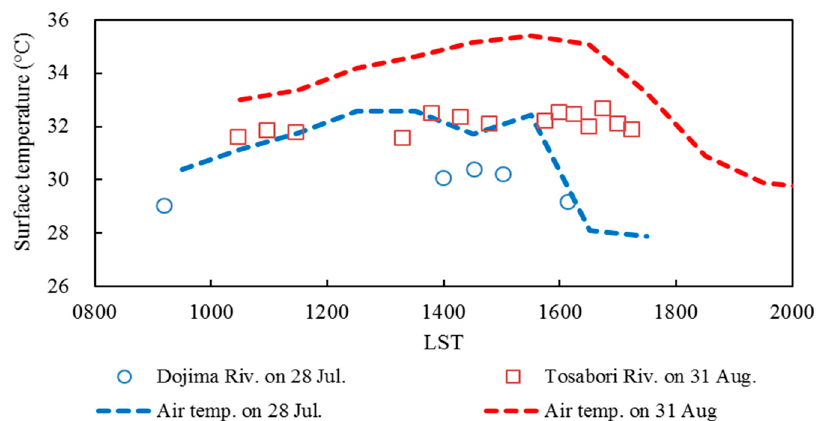
Figure 12. Surface temperature of the rivers and air temperature at ground level. The surface tempera-tures of the rivers were observed from a balcony of a hi-rise building at P3, using an IR thermography camera (see Figure 1b). The air temperature was observed at P2.